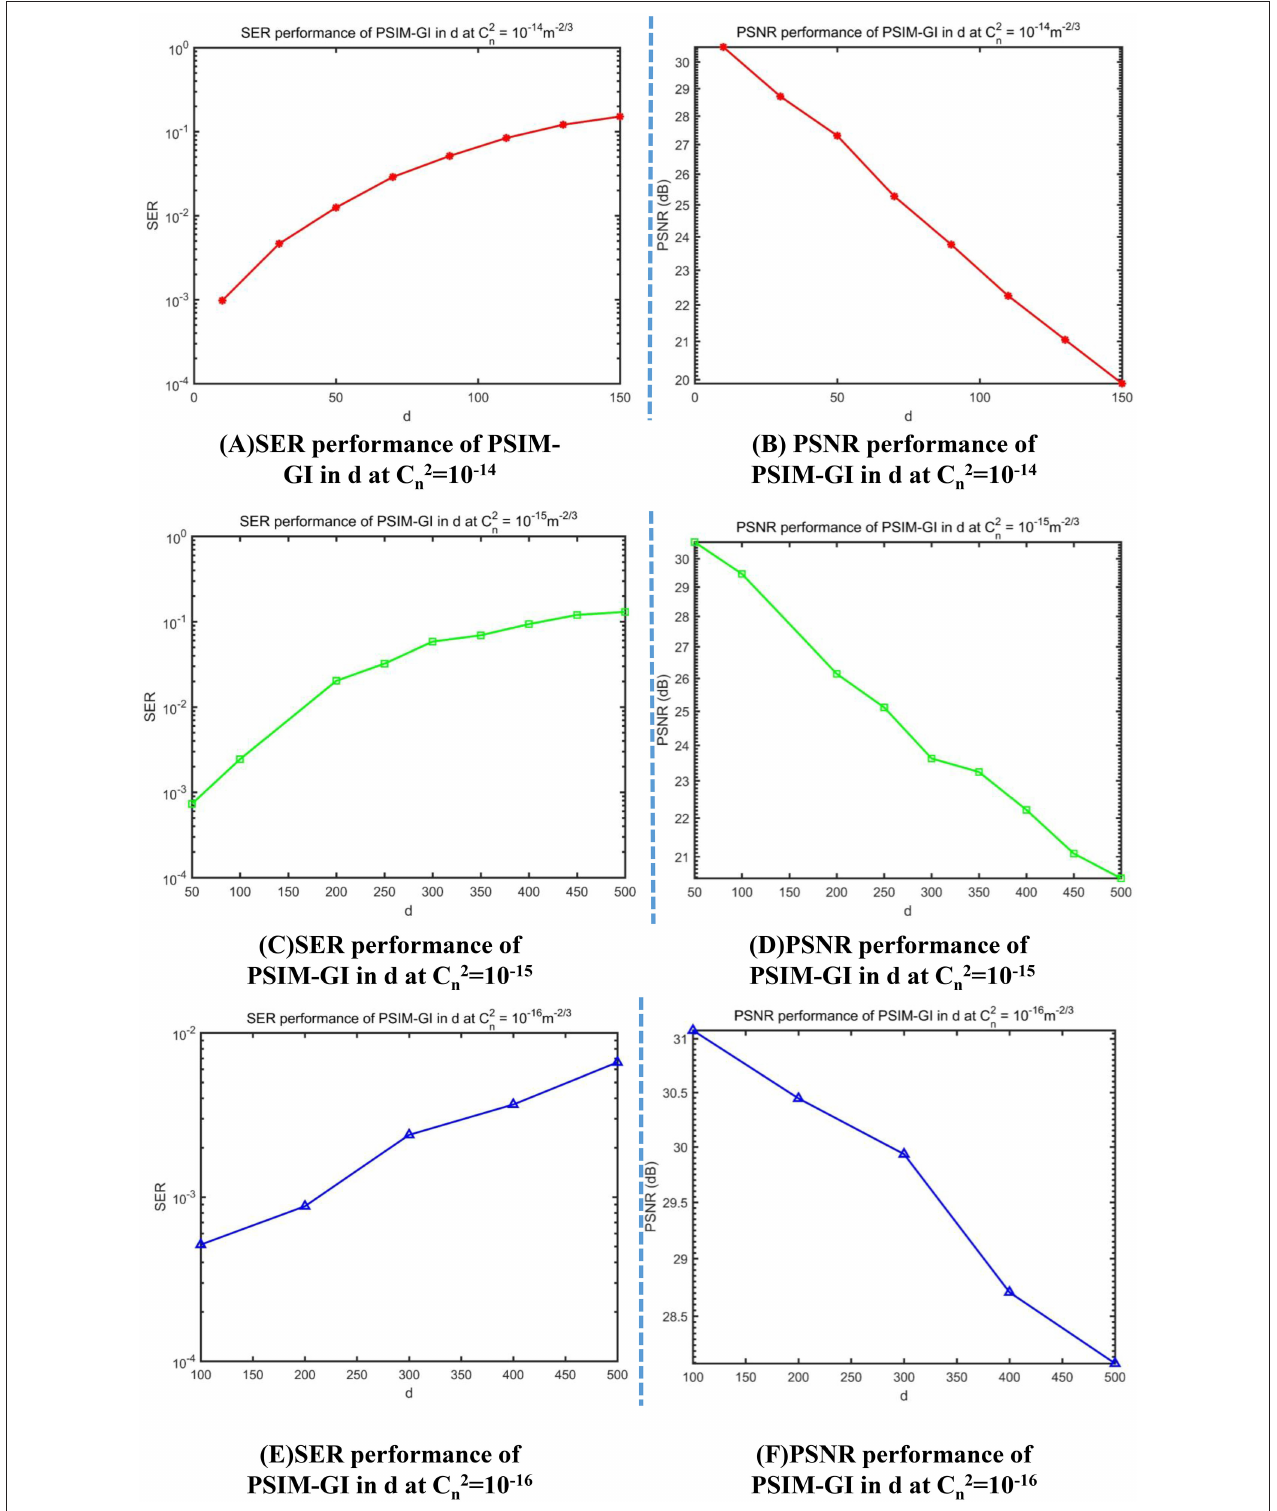
FIGURE 10 | Symbol-error rate (SER) and peak signal-to-noise ratio (PSNR) curves for various transmission distances. (A) SER performance of PSIM-GI in d at C 2 n 10 − 14 . (B) PSNR performance of PSIM-GI in d at C 2 n 10 − 15 . (E) SER performance of PSIM-GI in d at C 2 n